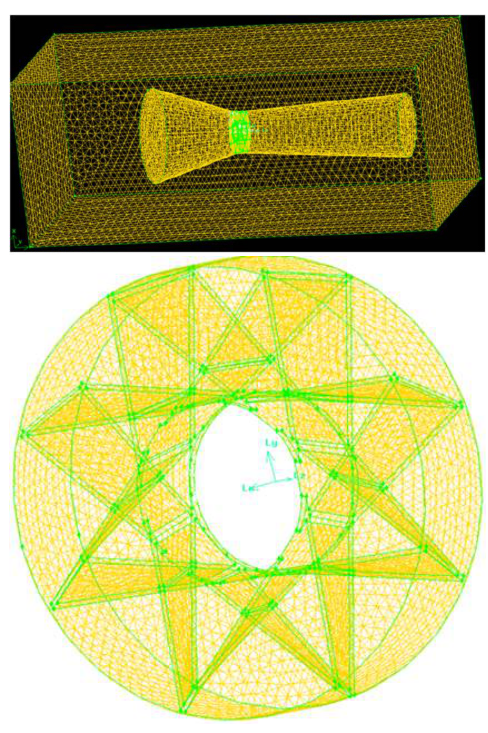
Figure 4. Mesh densities in the model for a CMMCT unit in free